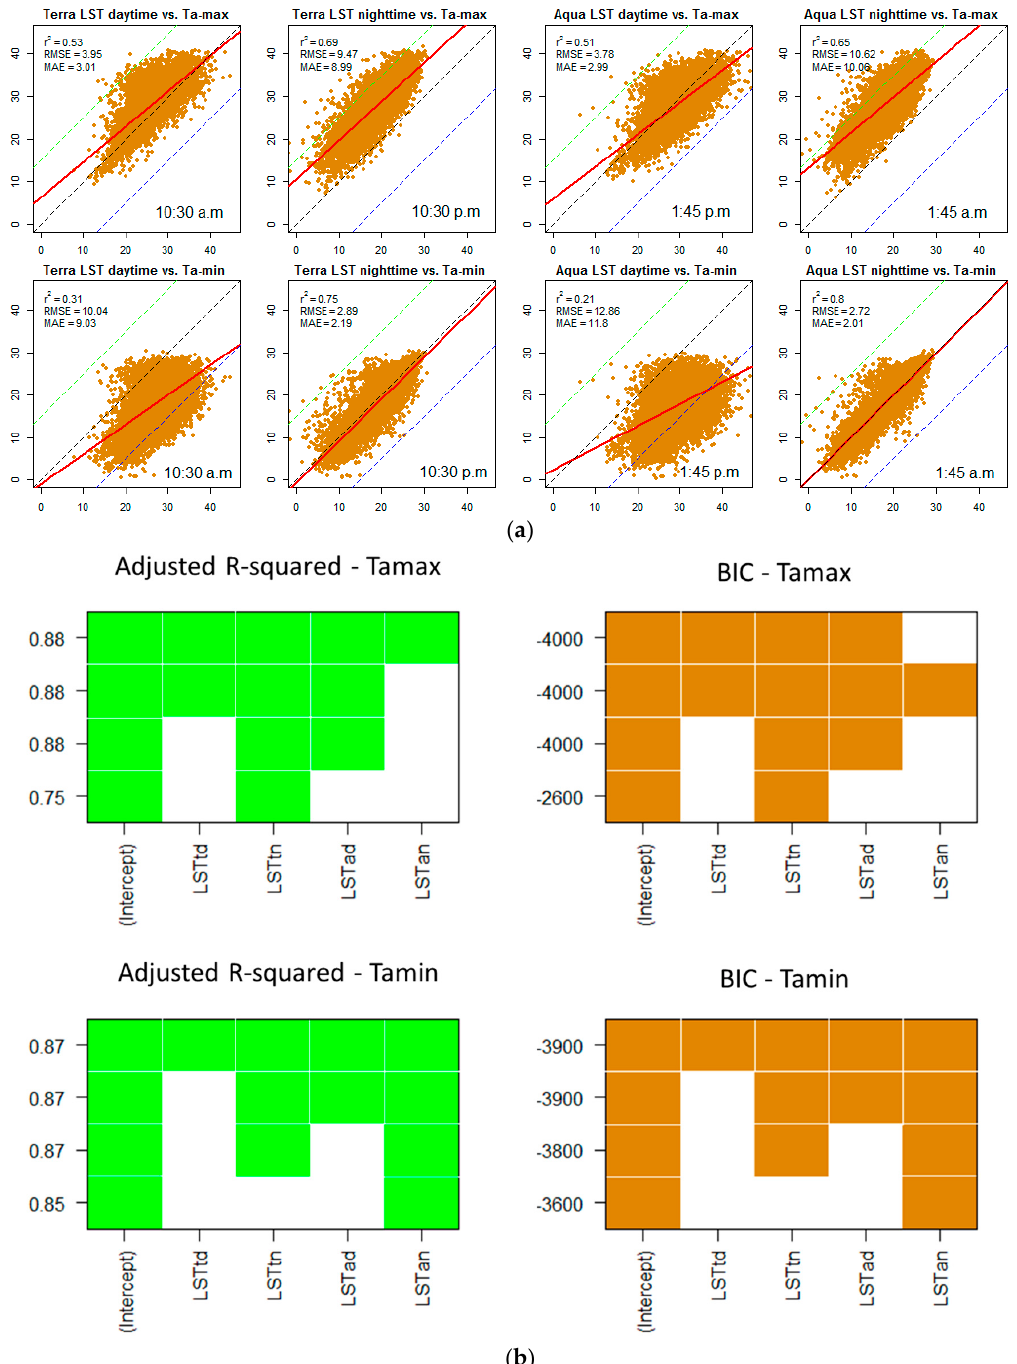
Figure 3. ( a ) The relationship between LST (x-axis) and T a-max ( upper panels ), T a-min ( lower panels ) of all meteorological stations from 2003–2013. The dashed green line indicates that the difference between T a and LST is over +15 °C; the dashed blue line indicates that the difference between T a and LST is lower than − 15 °C. The dashed black line indicates the 1:1 line. The solid red line shows the regression line. ( b ) Adjusted R-squared and BIC criteria show the top four models of T a-max ( upper panel ) and T a-min ( lower panel ) estimation using only the four LST dataset.